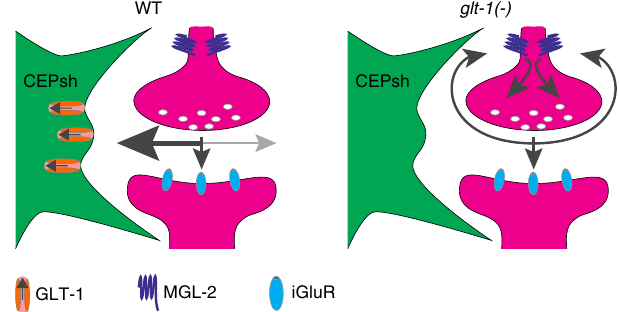
Fig. 7 Model for feedback excitation by glutamate spillover inducing repetitive reversal behavior. Under normal conditions (WT) glutamate (indicated by the gray arrows) is rapidly cleared from the synaptic cleft by glia-expressed GLT-1. In glt-1 mutants, glutamate is allowed to diffuse away from the synapse, resulting in activation of presynaptic MGL-2 and the induction of cycles of presynaptic